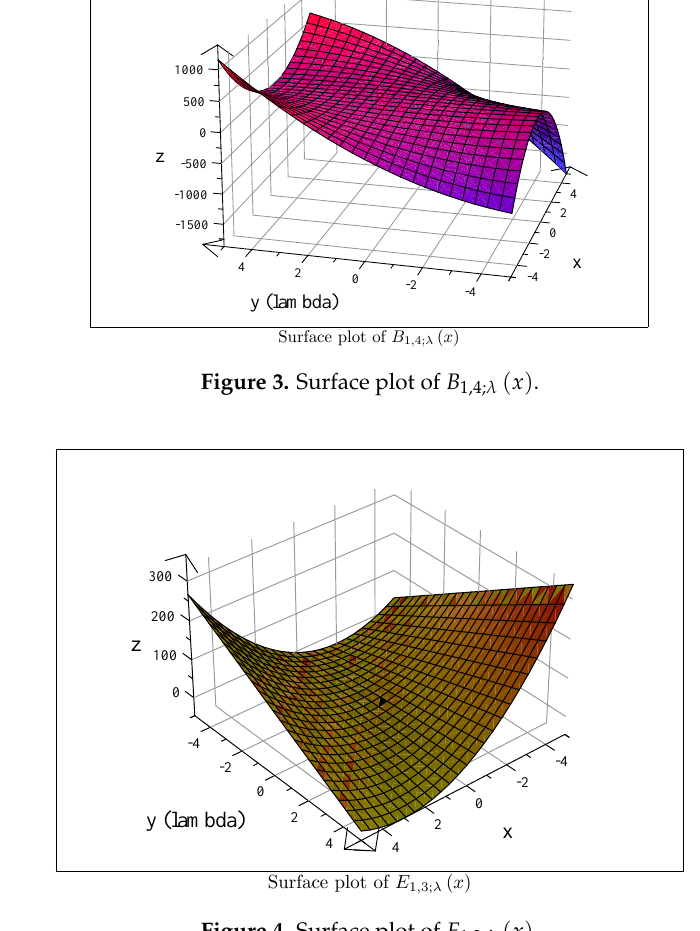
Figure 4. Surface plot of E 1,3; λ ( x )